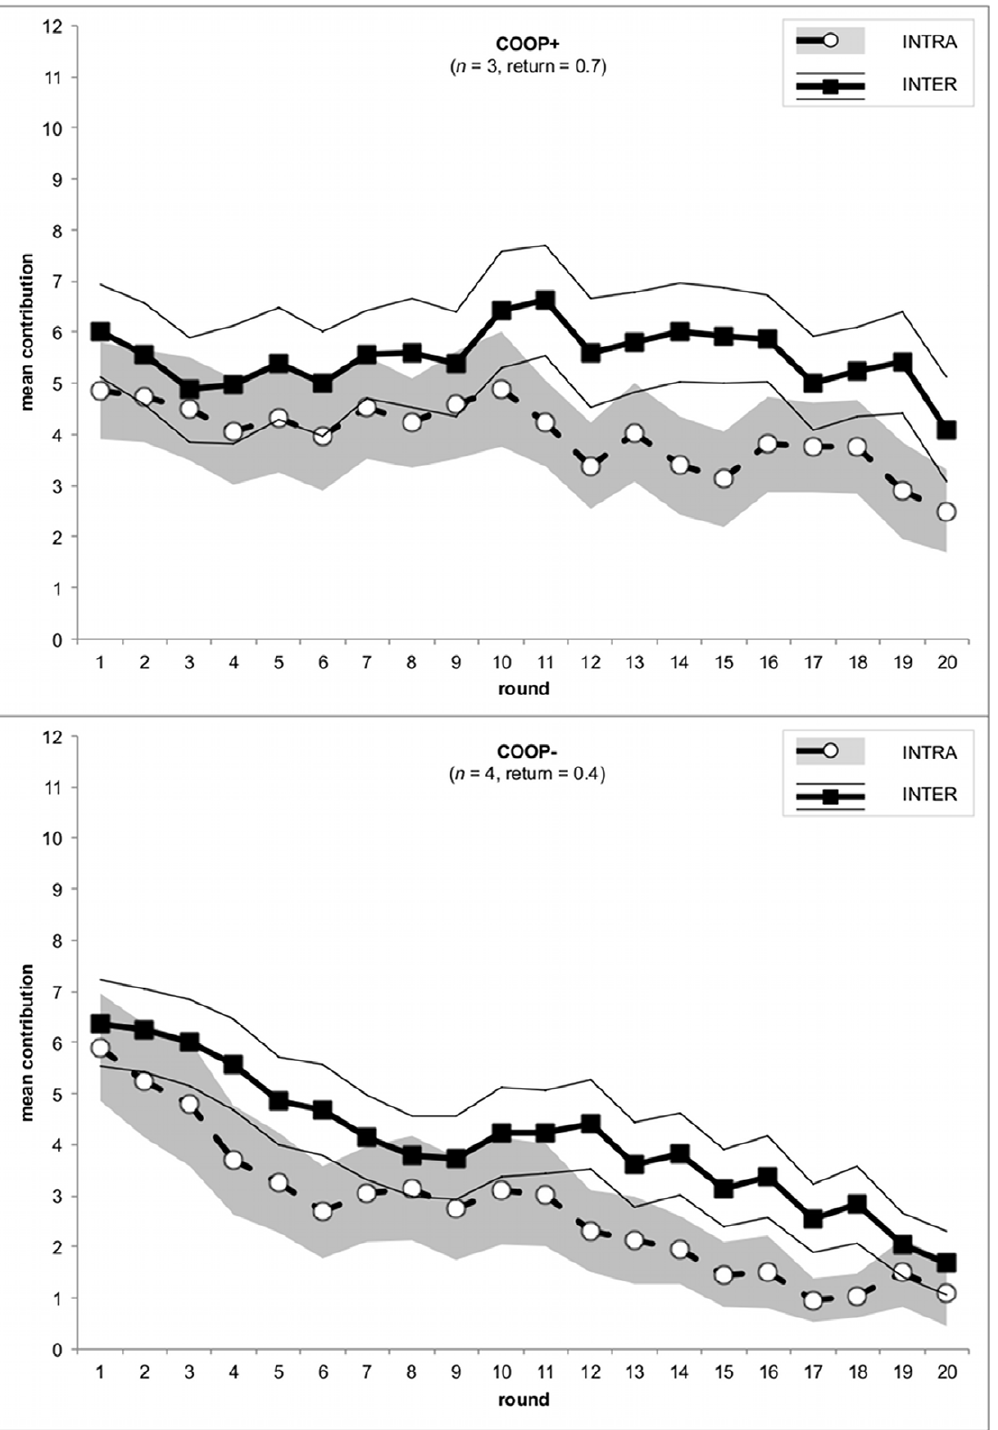
Figure 1. Mean contributions per round by comparison and environment treatments. Areas around mean values indicate 95% confidence intervals. positive and negative deviations in both the intra- and the inter- group comparison (model 2 in Table 2). In the case of intra-group comparison a positive deviation indicates a disadvantage (i.e. ‘‘I have contributed more than other group members.’’), while in the